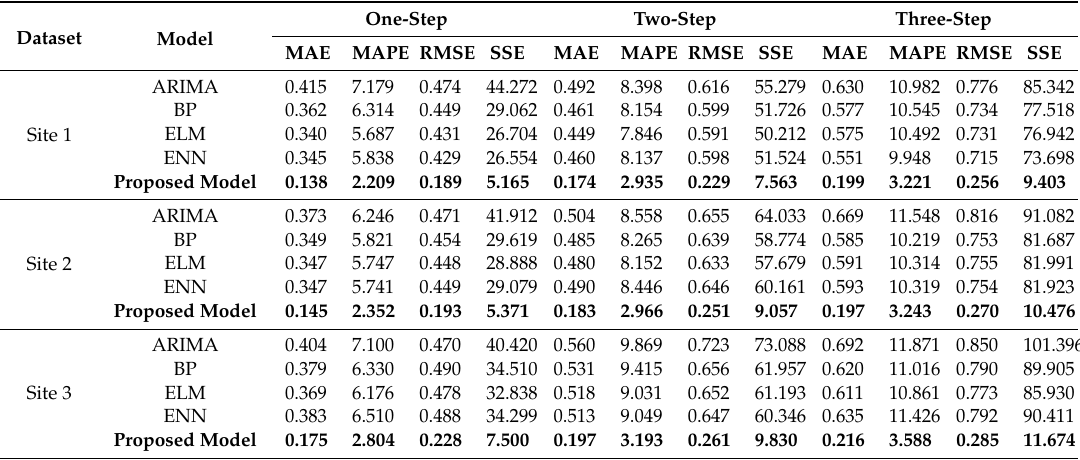
Table 7. Comparison of the evaluation metrics of the proposed model with benchmark